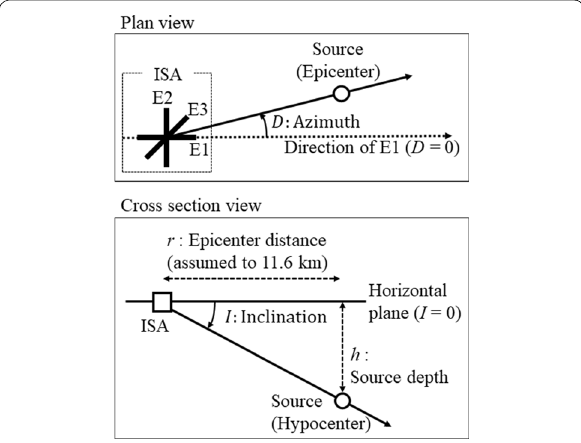
Fig. 4 A graphical representation of model parameters D , I , and r . D and I are estimated using ratios of the changes in E1, E2, and E3, whereas r needs to be estimated a priori